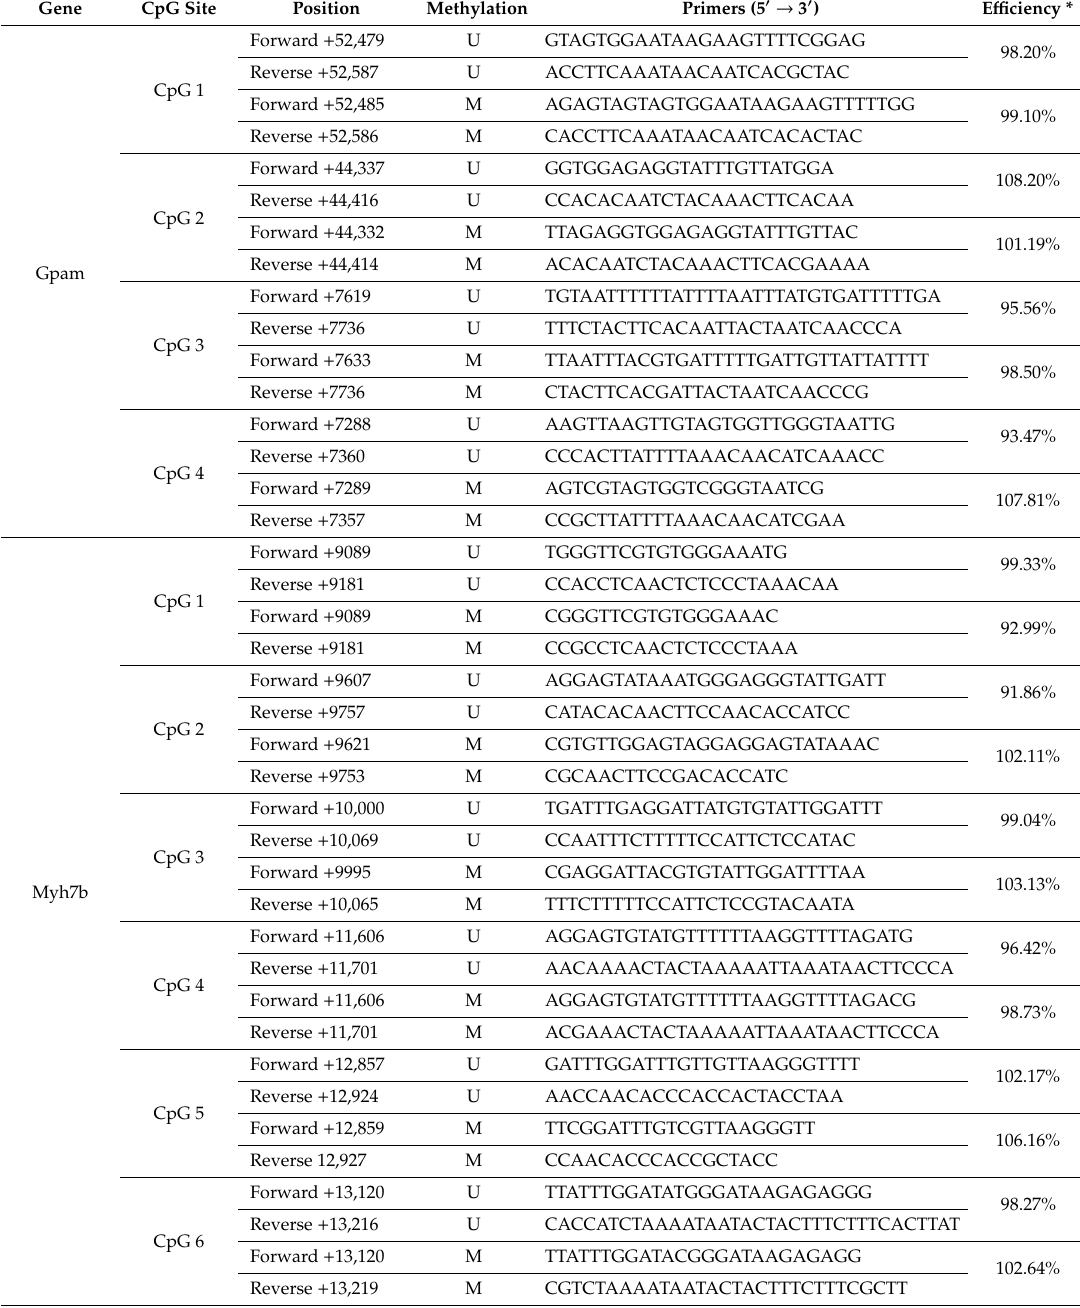
Table 1. Methylation specific PCR (MSP)